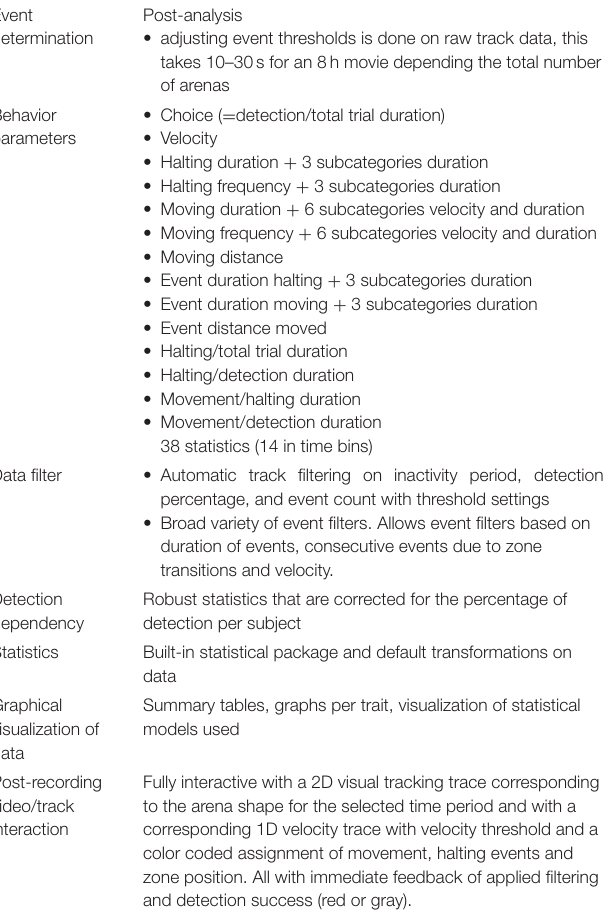
TABLE 3 | Features of EthoAnalysis for analyzing insect behavior. Event